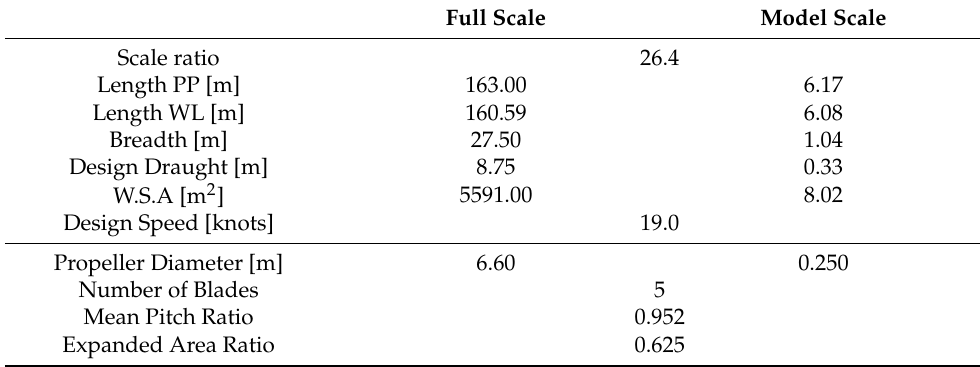
Table 2. Principal parameters of the mother ship and propeller (1800 TEU Container Ship).